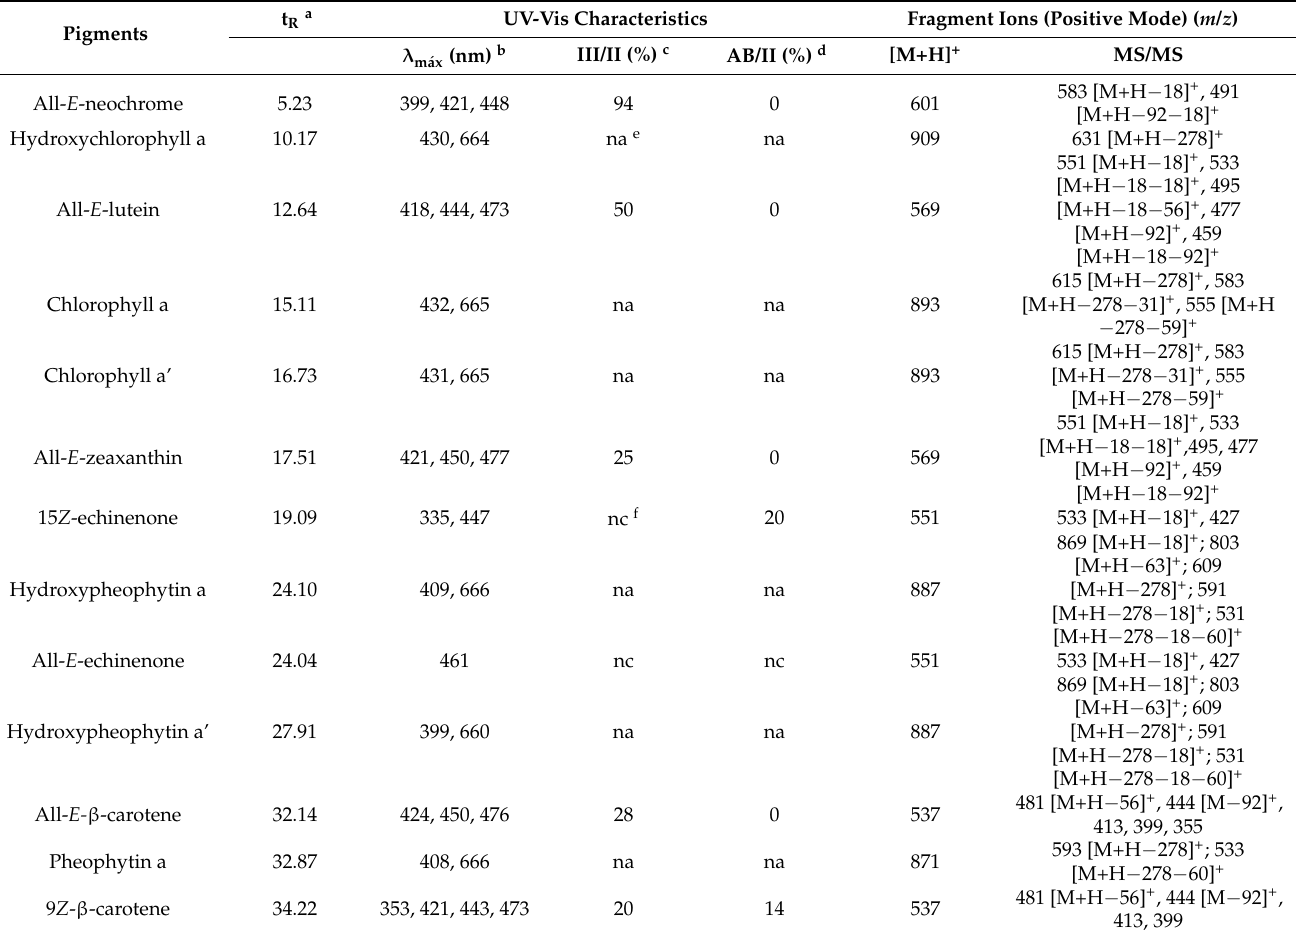
Table 1. Chromatographic, UV–vis spectrum, mass characteristics of C. calcitrans pigments obtained by